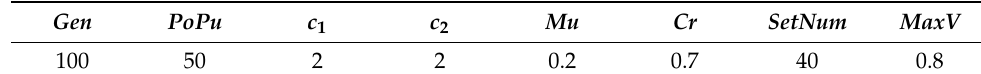
Table 4. Algorithm parameter values.